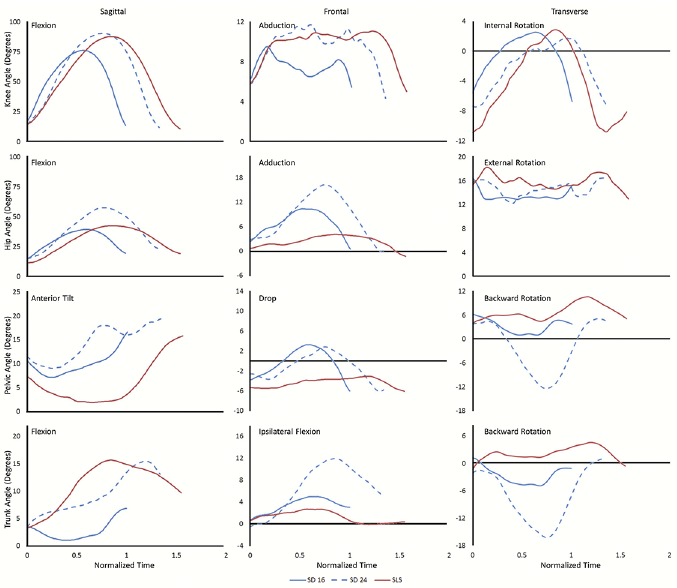
Fig 3. Average knee, hip, pelvis and trunk angles from a representative participant performing each of the three tasks. As the task durations were not equal, data were normalized to maintain the time differences between tasks for presentation purposes